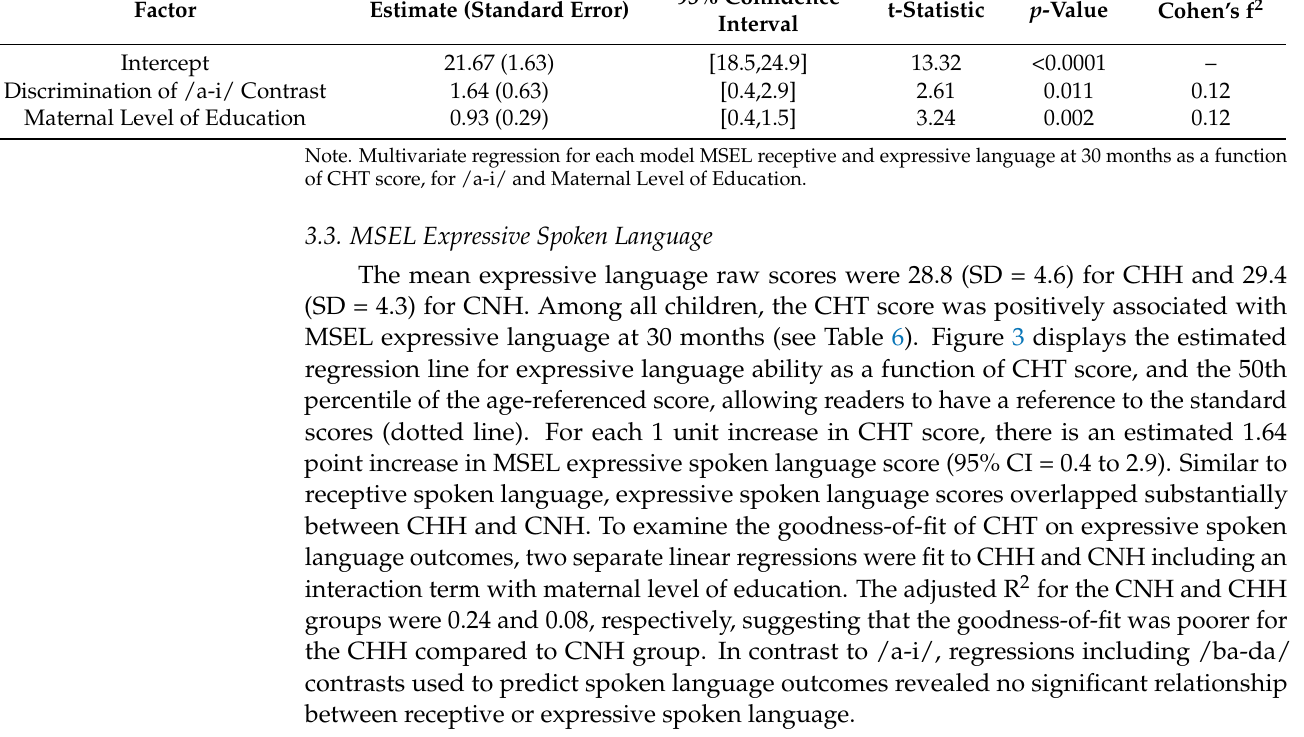
Figure 4. Hearing status as a function of performance on the MSEL Note: Normal Hearing (NH); Mullen Scales of Early Learning (MSEL); Performance on MSEL Receptive ( left panel ) and MSEL Expressive ( right panel ) Hearing status (normal hearing in green, mild in orange, and >moderate in purple). Box plot represents the minimum, first quartile, median, third quartile and maximum. Dots represent participants 2.70 standard deviations or more from the mean. Question 3. At 30 months of age, will scores from a parent questionnaire of their child’s spoken language inventory significantly correlate with their assessed early receptive and expressive spoken language ability?